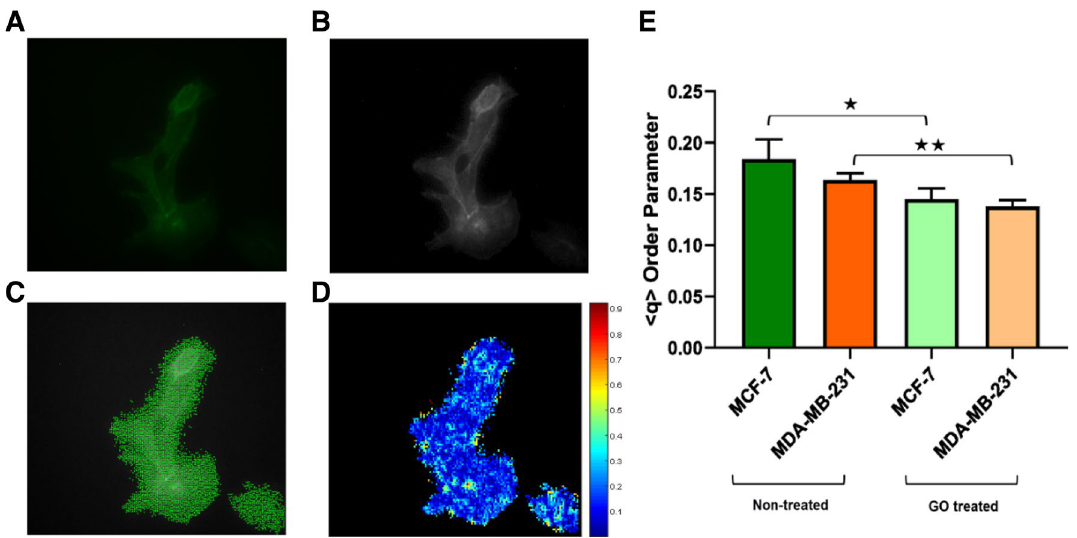
Figure 5. Effect of GO nanosheet on F-actin order parameter in MDA-MB-231 and MCF-7 cell lines. ( A ) Fluorescence F-actin network images, ( B ) and the masked image of fluorescence image, ( C ) The local orientation of actin filaments in the fluorescence image, ( D ) Heat map of order parameter < q > for MDA-MB-231 and MCF-7 cell lines non-treated and GO nanosheet treated, ( E ) The statistical analysis of the effect of GO on average of the order parameter of actin filaments in MCF-7 and MDA-MB-231 cell lines. The data represent the mean ± standard deviation of the order parameter of MCF-7 and MDA-MB-231 cell lines were obtained from three independent experiments. Two-way ANOVA was used to analyze the difference between treated and control groups and * P < 0.05, ** P < 0.01, *** P < 0.001, and **** P <